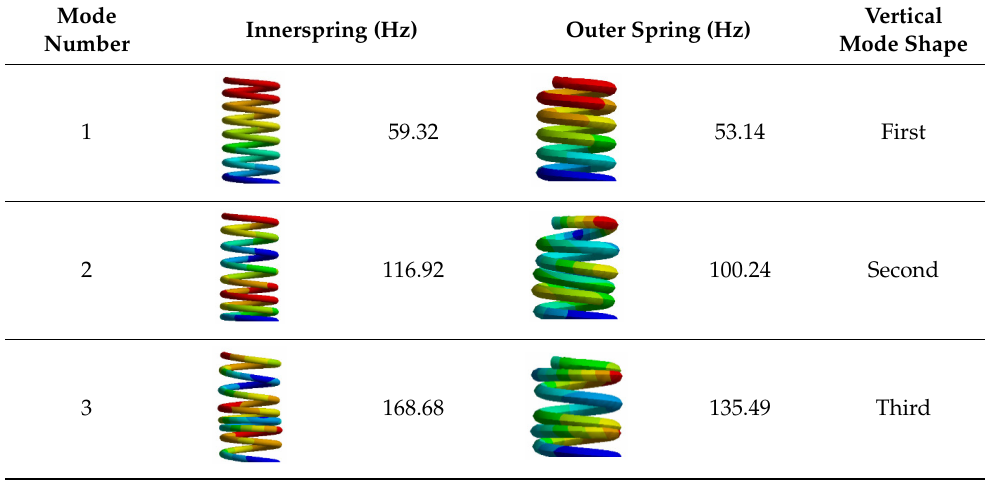
Table 2. Modal analysis for the first three vertical mode shapes for inner and outer